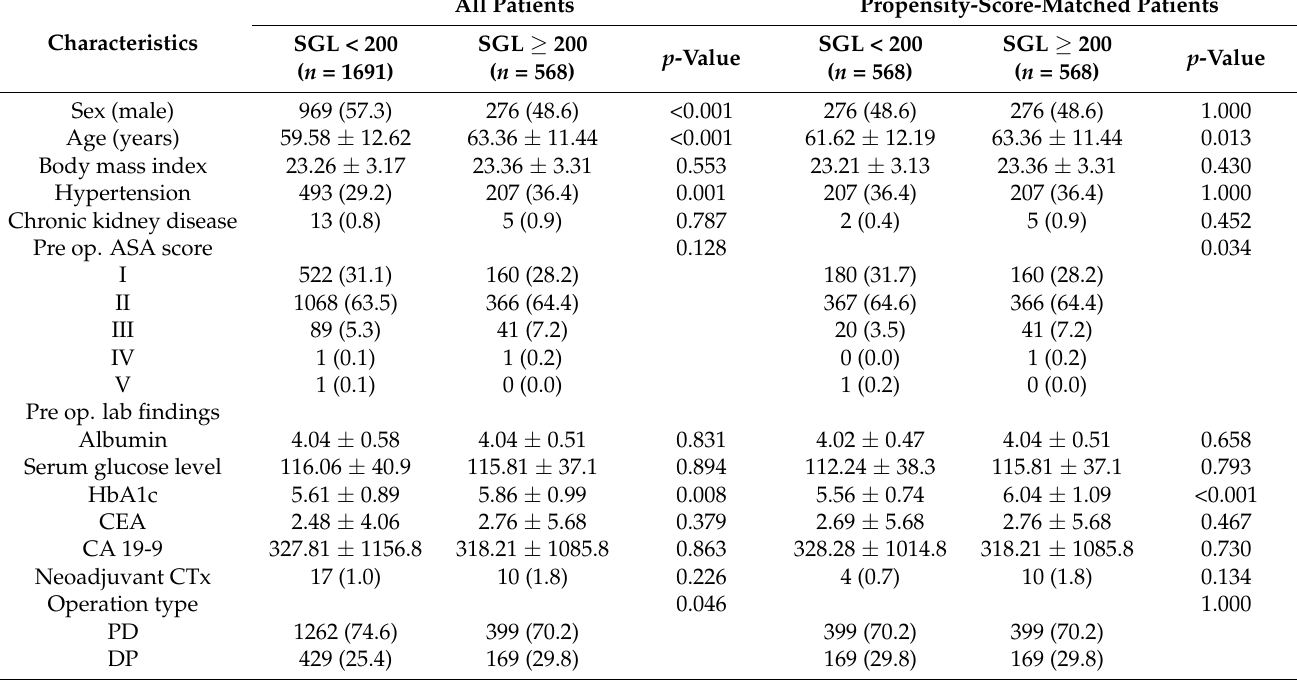
Table 1. Preoperative